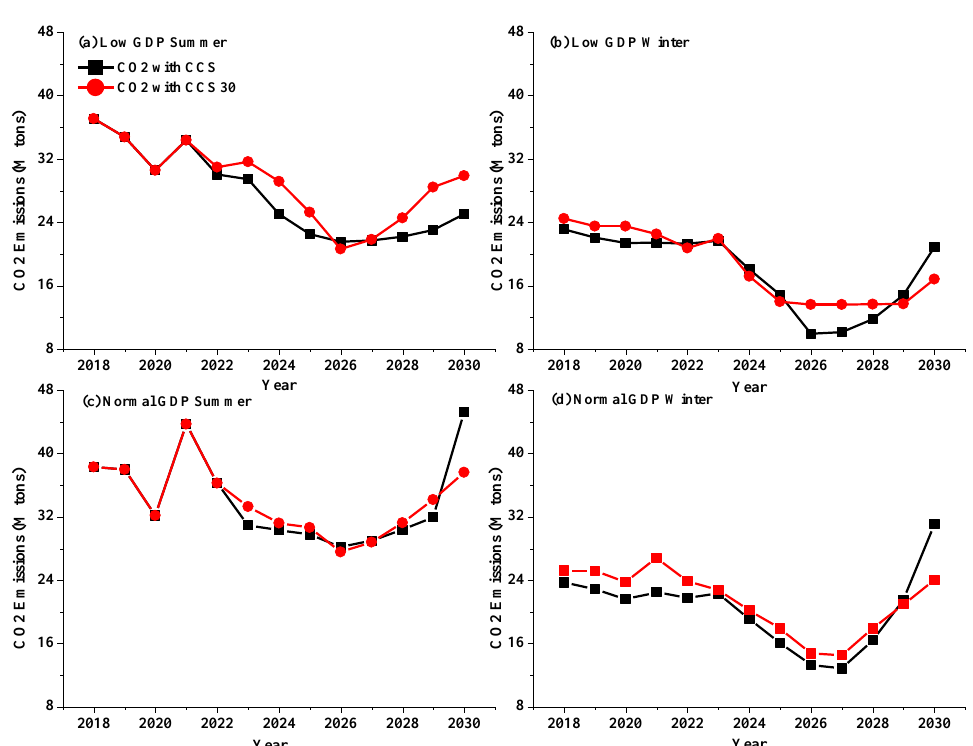
Figure 14. CO 2 emissions for CCS case at 30% operational constraint on fossil fuel based power plants compared with the CCS case without such constraint. Energies 2020 , 13 , x FOR PEER REVIEW 23 of 36